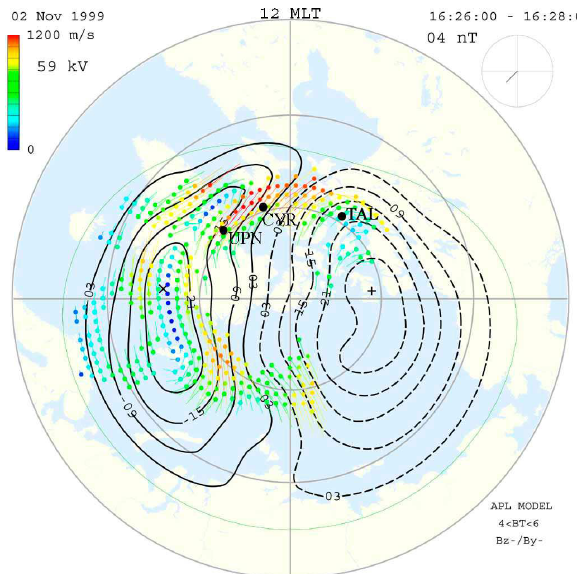
Fig. 4. Ionospheric convection flow channel centered at 12 MLT: a source of TID 2. Magnetometer locations near the cusp footprint are shown.